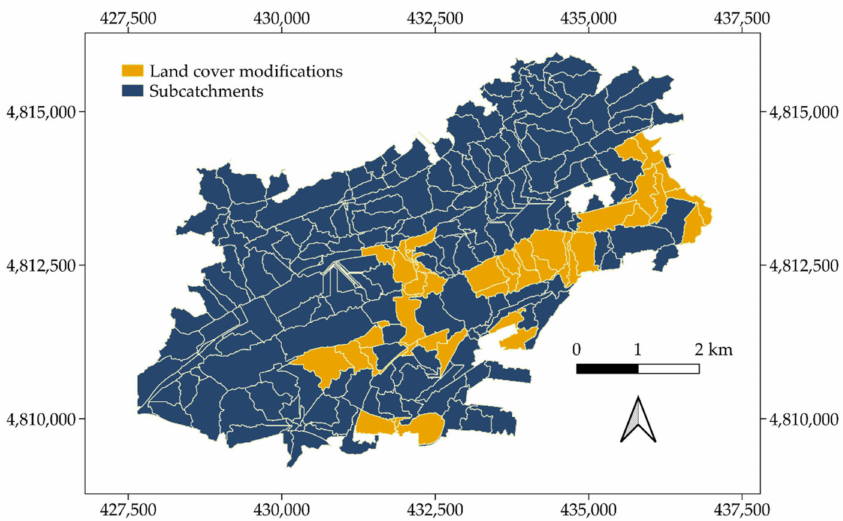
Figure 8. Shortlisted subcatchments to test different land cover modifications for reducing runoff